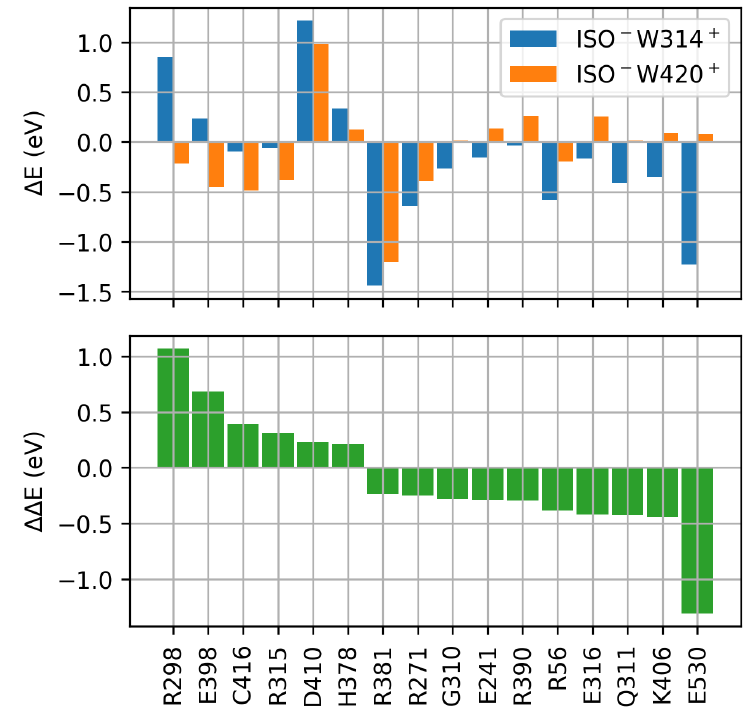
Figure 3. Impact of dCRY amino acid residues on CT states ISO − W420 + (Trp triad) and ISO − W314 + (CTT proximate), positive ∆ E correspond to a destabilization, negative ∆ E to stabiliziation of CT states ( top ). Relative stabilization/destabilization of ISO − W420 + and ISO − W314 + states ( bottom ), positive ∆∆ E denote the relative stabilization of the Trp triad state ISO − W420 + while negative ∆∆ E favors the CTT proximate state ISO − W314 +